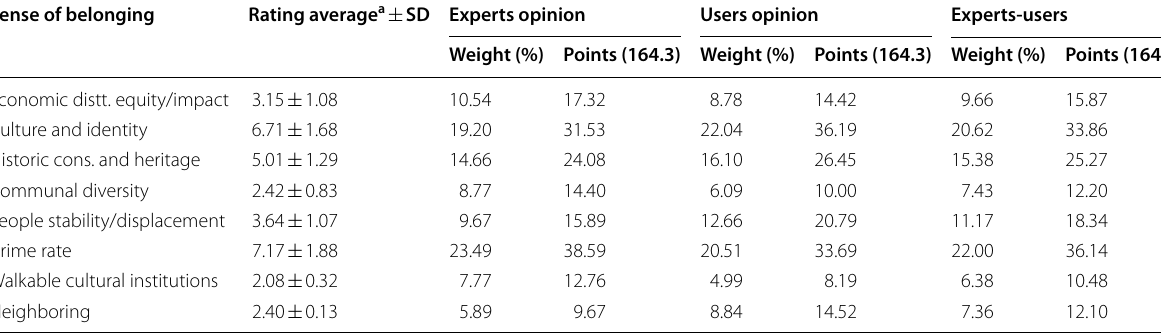
Table 6 Rating and distributed weight of factors in the sense of belonging